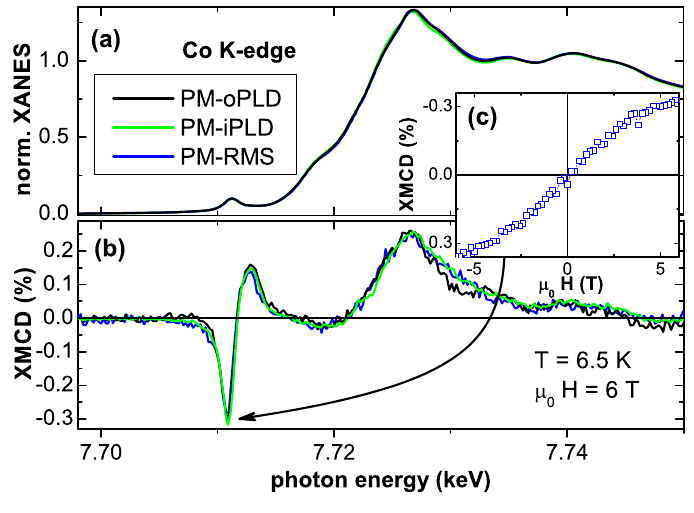
Figure 7. (a) normalized XANES and respective XMCD (b) at the Co K -edge of three PM Co:ZnO samples recorded at 6.5 K applying ± 6 T in the film plane. (c) shows the element specific M ( H ) -curve as measured at the photon energy of the pre-edge feature of the PM-RMS